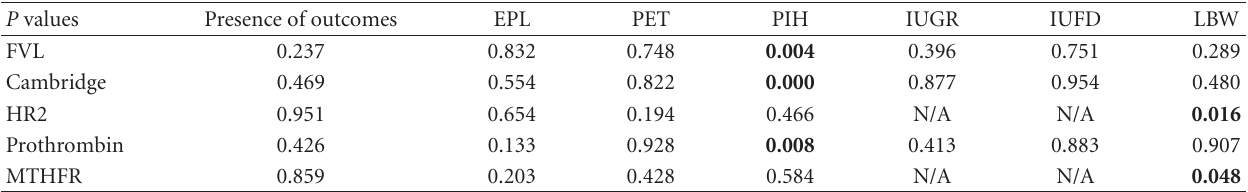
Table 5: Results from Pearson Chi-Square test. P values for the association between each adverse pregnancy outcome identified in this study and thrombophilic mutations indentified in our total study cohort n =